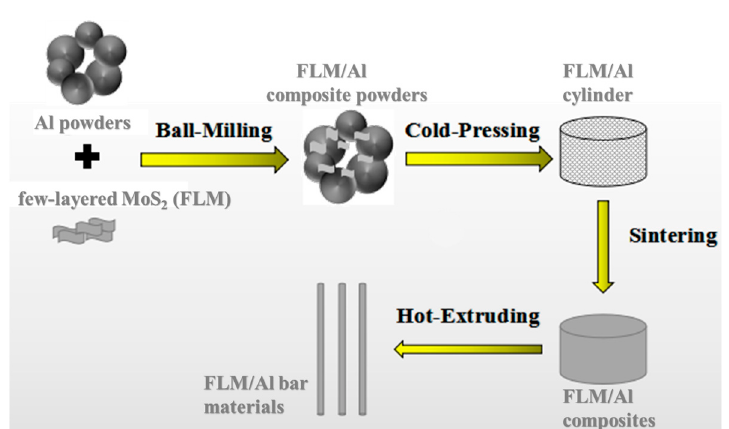
Figure 1. Schematic illustration of the fabrication process of FLM/Al bulk composites.